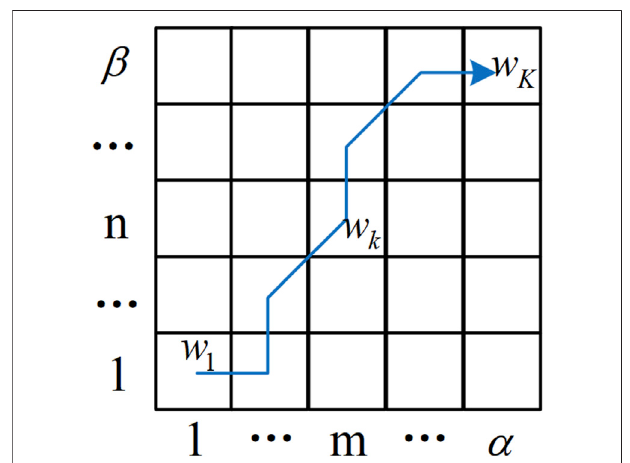
FIGURE 6 | Principle diagram of warping path. The warping path needs to satisfy the following